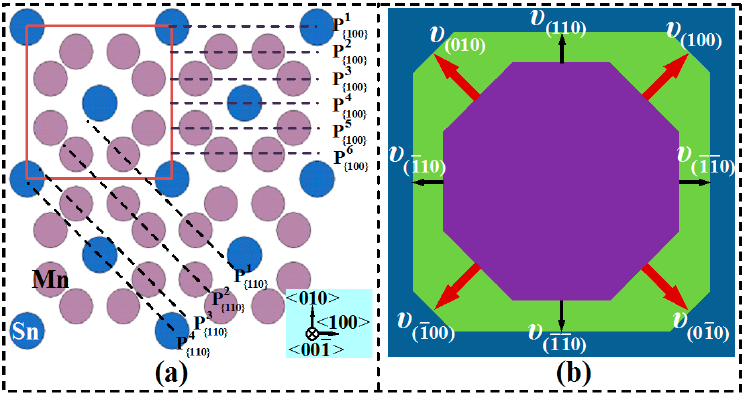
Figure 4. < 001 > projection view ( a ) of the MnSn 2 structure; schematic diagram ( b ) illustrating the shortening and disappearance of the {100} planes due to their faster growth rate than the {110} planes (the octagonal base tends to develop into a square base). The rectangular frame in ( a ) encloses a unit cell. The dashed lines in ( a ) indicate the (P 1 { and {110} interplanar spacing periods, respectively. υ with the subscripts referring to the planes in ( b ) indicate the growth rates of the {100} and {110} planes, respectively.